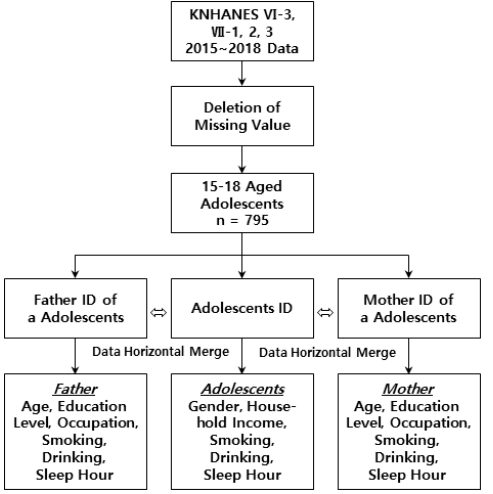
Figure 1. Study model design.